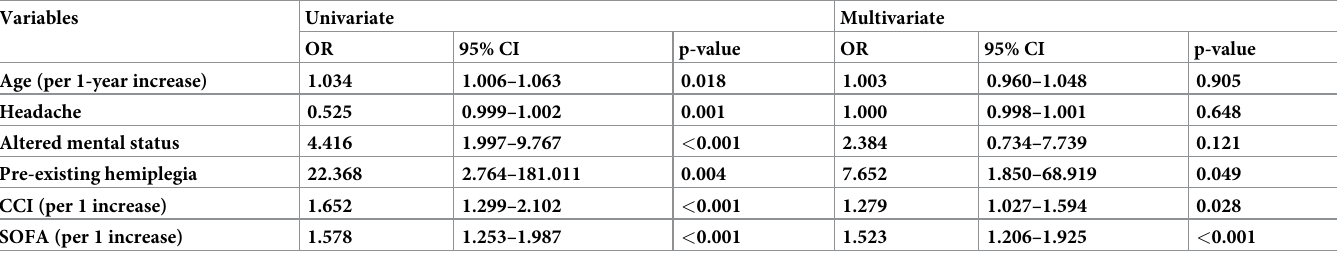
Table 4. Uni- and multivariate analysis of risk factors for unfavorable clinical outcomes in patients with brain abscess.